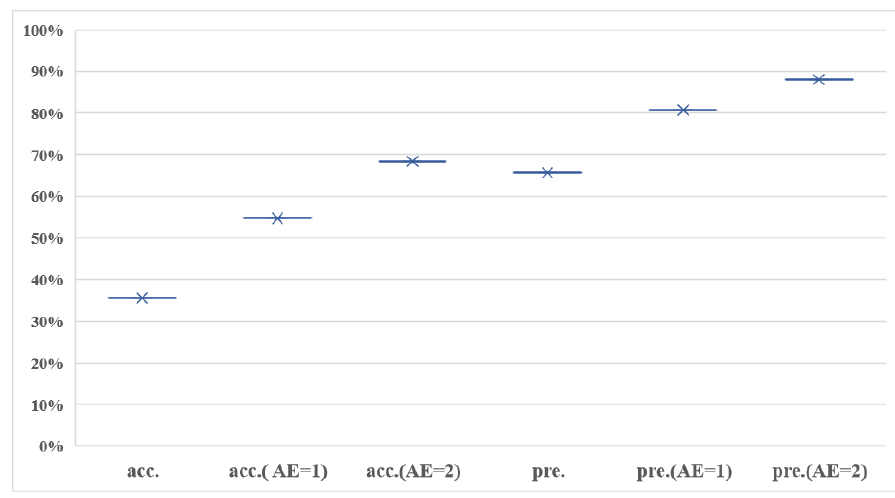
Figure 13. The performance of pre-trained EM.